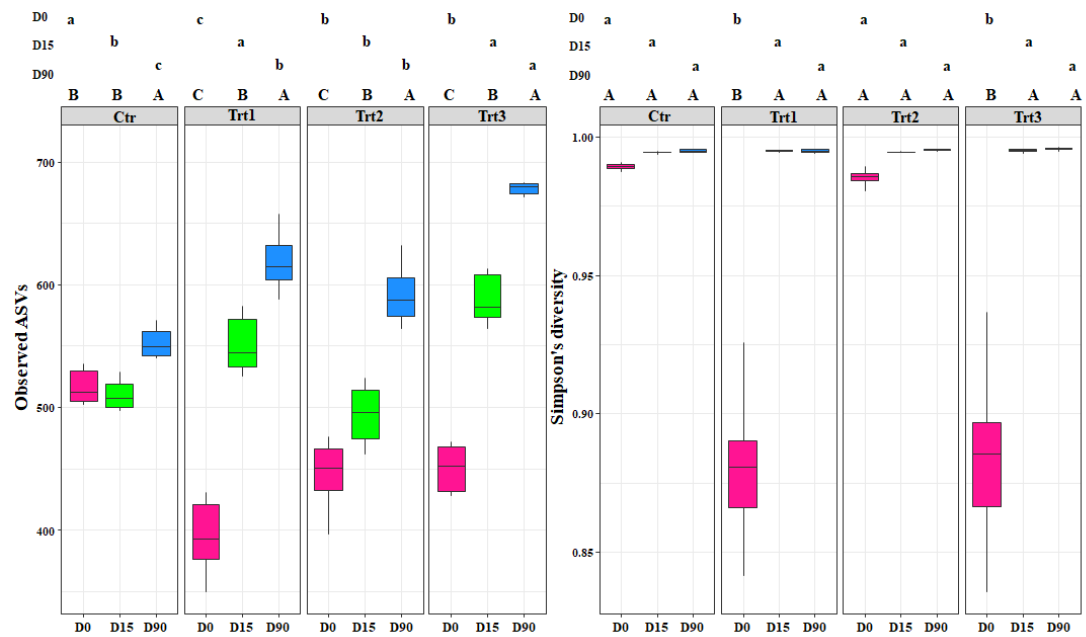
Figure 2. Boxplots of the bacterial richness (observed ASVs) and bacterial diversity (Simpson’s diversity) at different sampling times (D0: after 12 h; D15: after 15 days; D90: after 90 days). Ctr: bulk soil; Trt1: soil with 10 g of beech wood pellets; Trt2: soil with Trichoderma atroviride SC1 conidial suspension at the rate of 5 × 10 3 conidia · g − 1 of soil; Trt3: soil with 10 g of T. atroviride SC1 coated beech pellets (5 × 10 5 conidia · g − 1 of beech wood pellets). Letters indicate significant differences according to the emmeans package ( α = 0.05) between treatments at each sampling point (lower case letters) or for the same treatment over time (upper case letters). Data of the two experiments E1 and E2 were pooled.